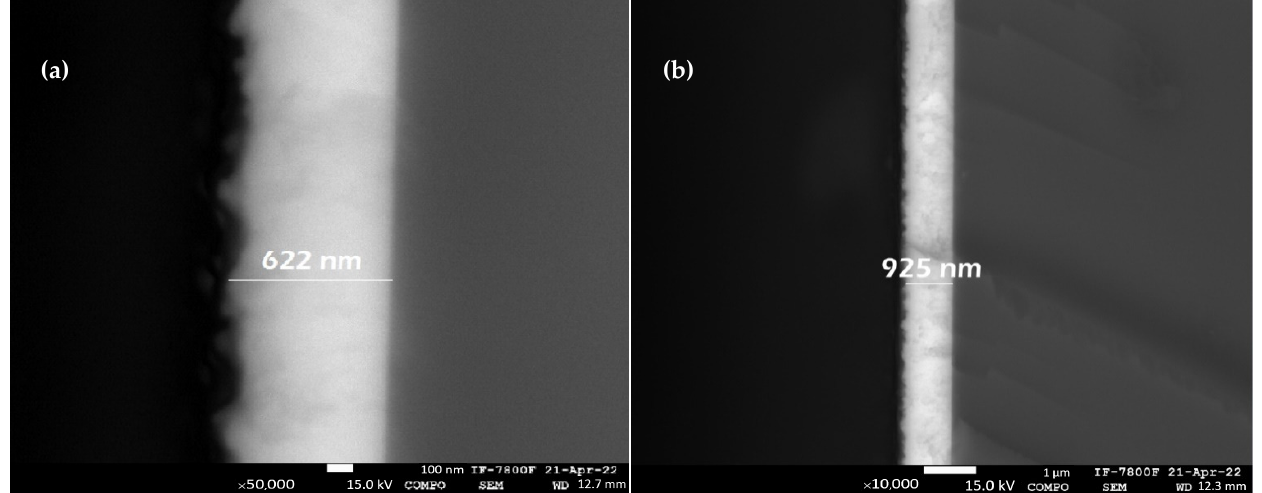
Figure 3. Cross-sectional micrographs of ( a ) deposition made on a fused silica substrate and ( b ) deposition made on a glass substrate. A film thickness label is added to both micrographs.